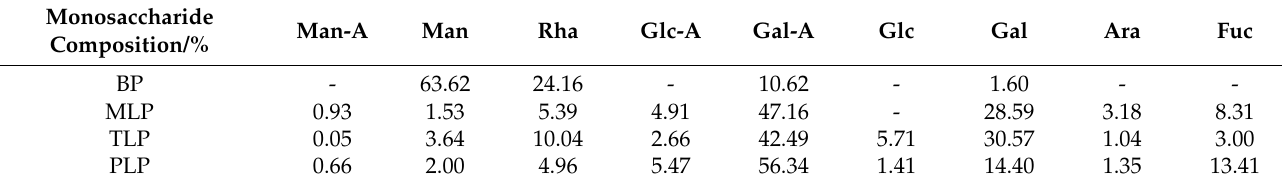
Table 1. Monosaccharide composition of BP and